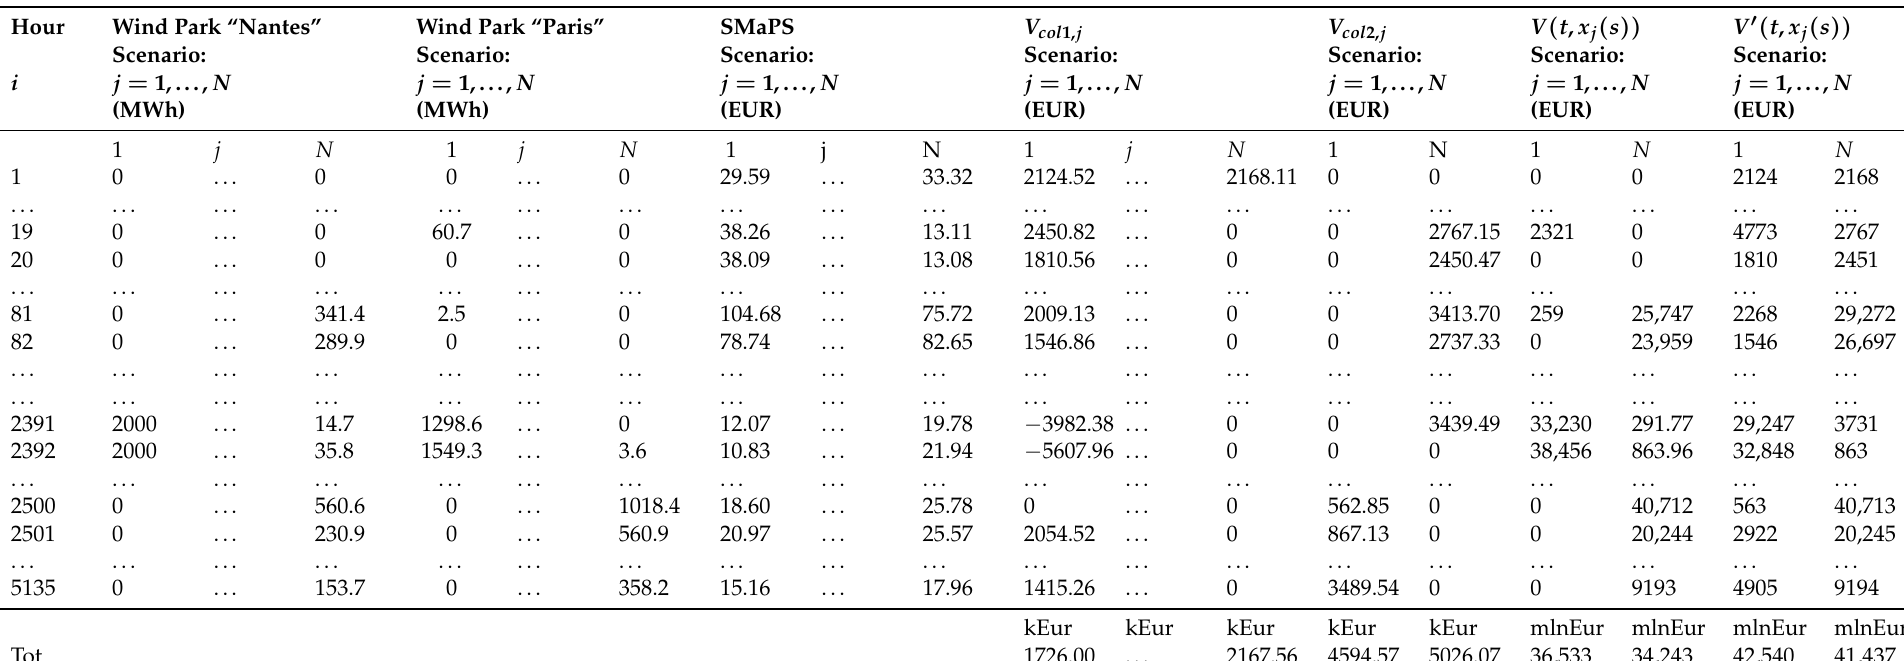
Table 6. Density profit margin evaluation before and after hedging strategy, using spot price and load scenarios for the 5135 single hours of the front